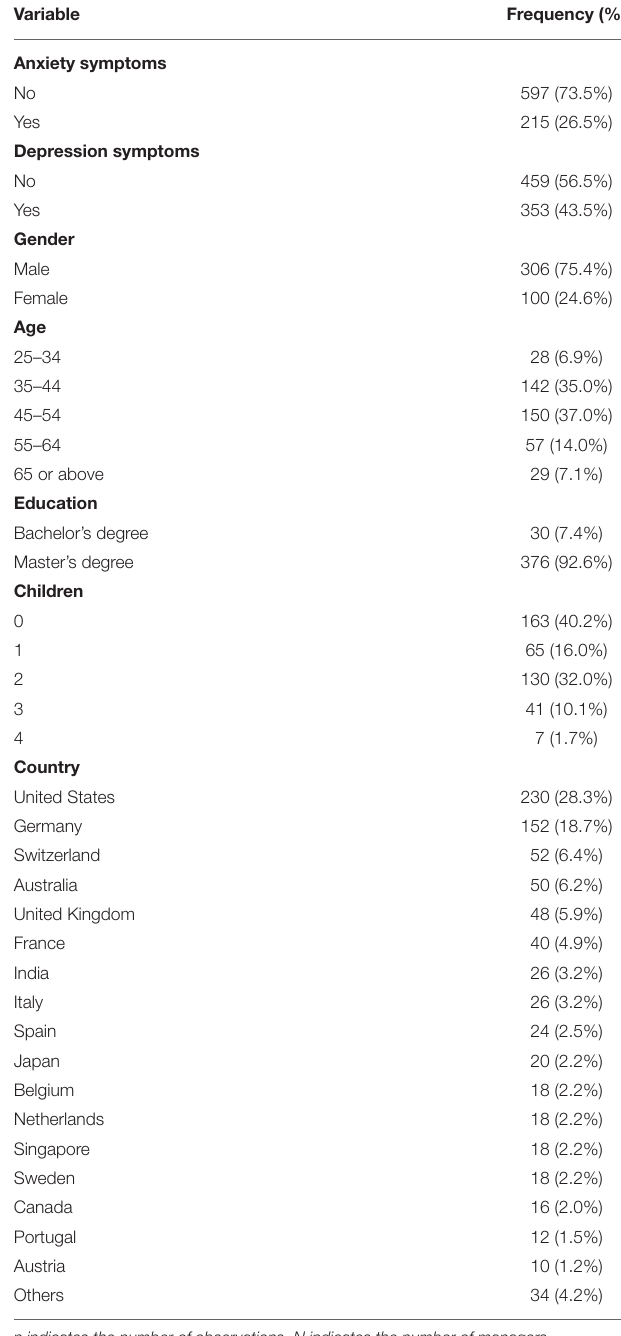
TABLE 1 | Descriptive statistics ( n = 812, N =